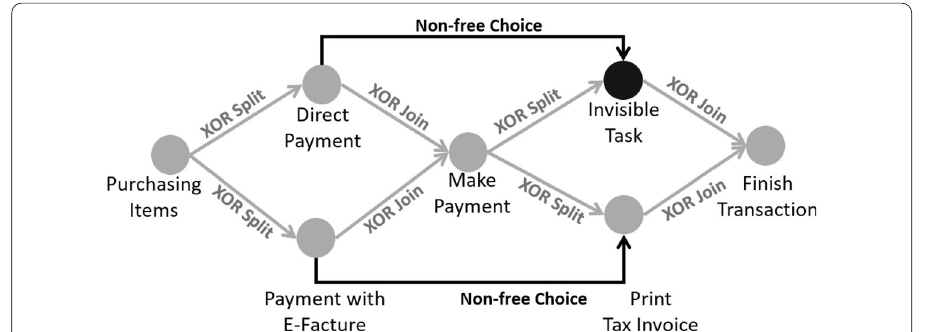
Fig. 2 A process model of purchasing medical